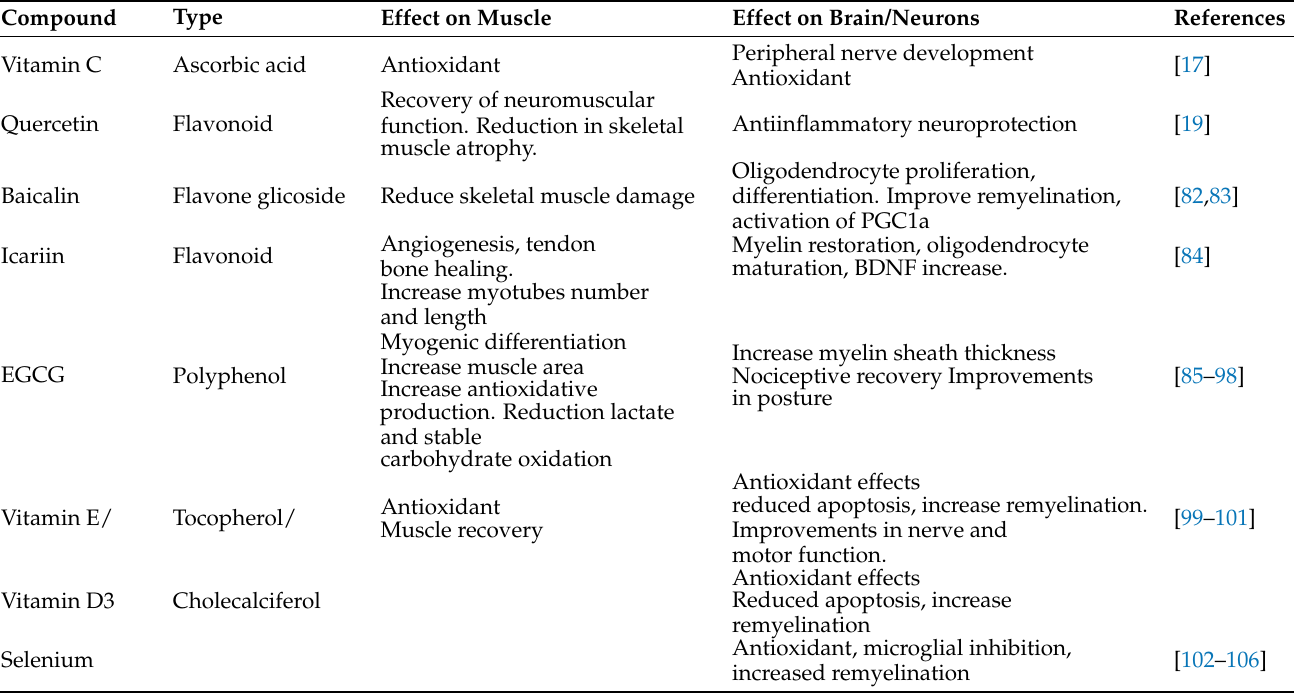
Table 1. Exogenous antioxidant effects on muscle and nerve